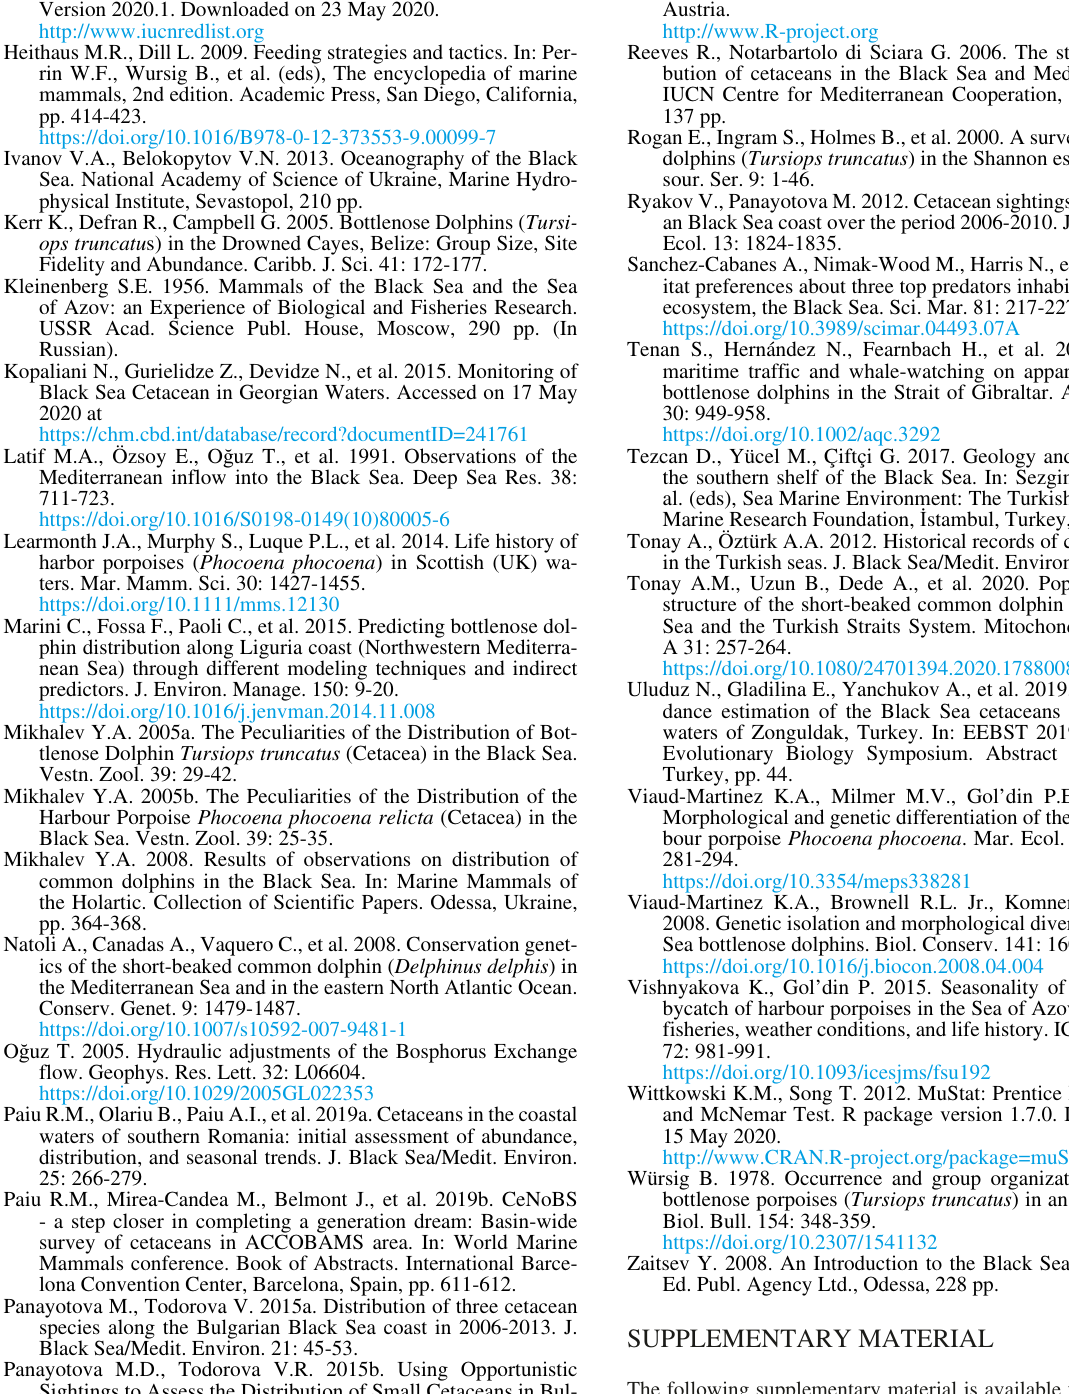
Table S1. – Decomposition of the sighting frequency time series into three components. Table S2. – Decomposition of the group size time series into three